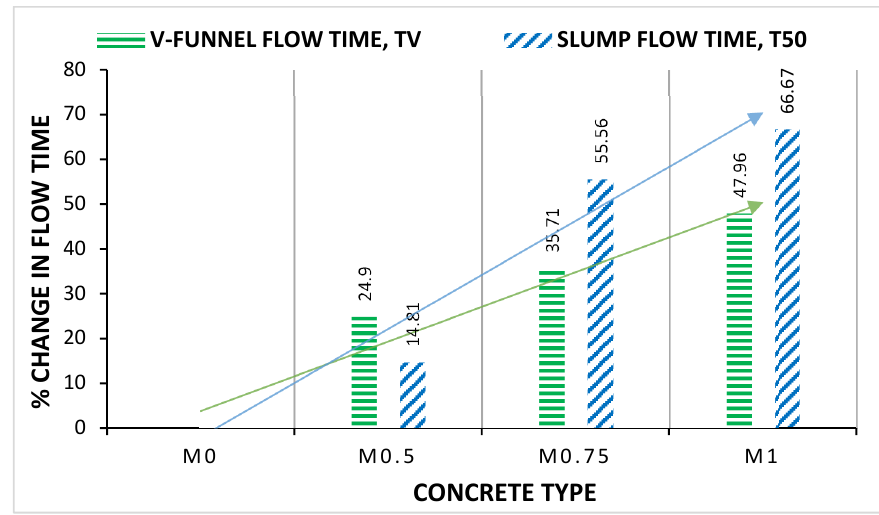
Figure 10. Percentage changes in both flow time parameters, TV and T50.